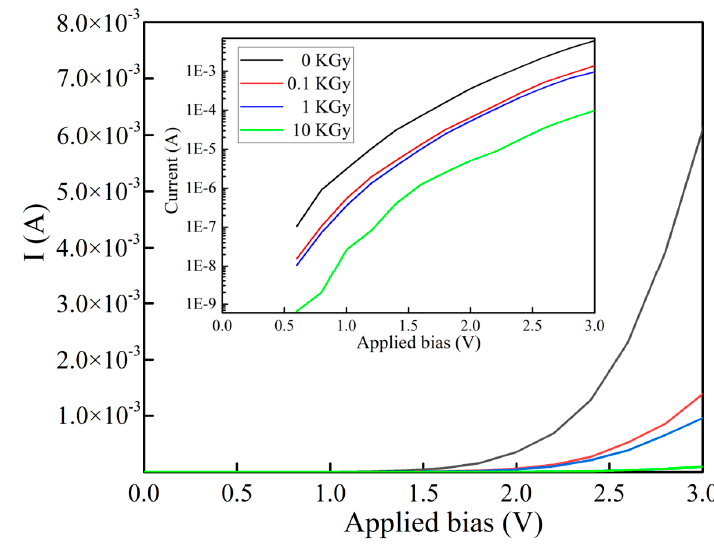
Figure 6. The I-V curve of Si-doped GaAs at 3 V bias voltage under di ff erent γ -radiation doses (0, 0.1, 1 and 10 KGy). Inset shows the same graph in logarithm